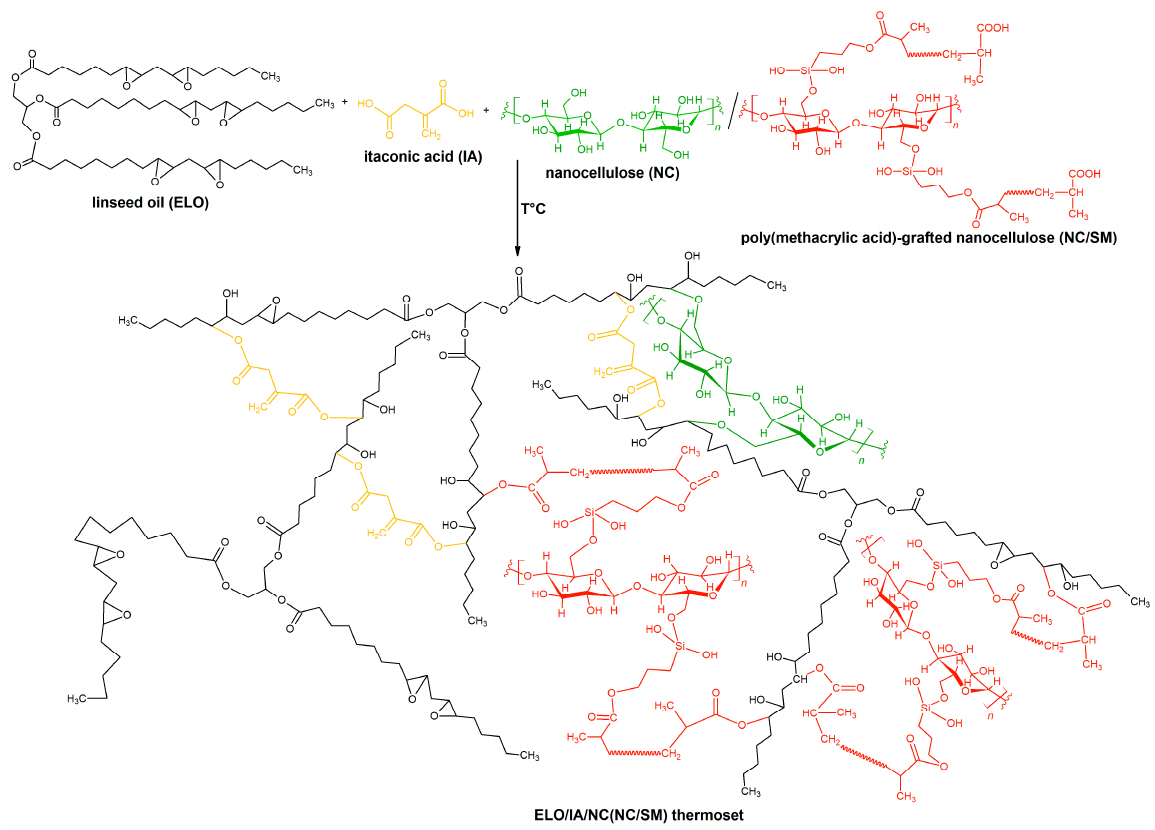
Figure 4. TGA, DTG and inset from 150 to 400 ° C for the neat epoxy system and epoxy nanocom-